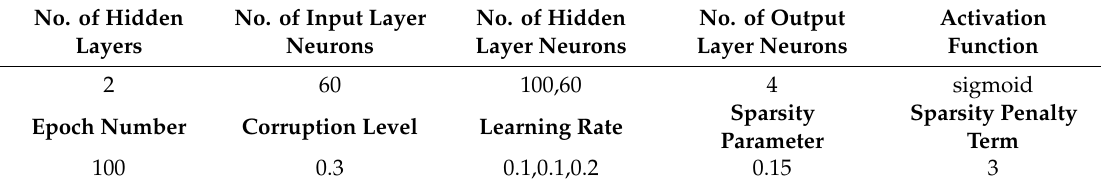
Table 3. The proposed stacked sparse denoising autoencoder (SSDAE) network parameters. No. of Hidden Layers